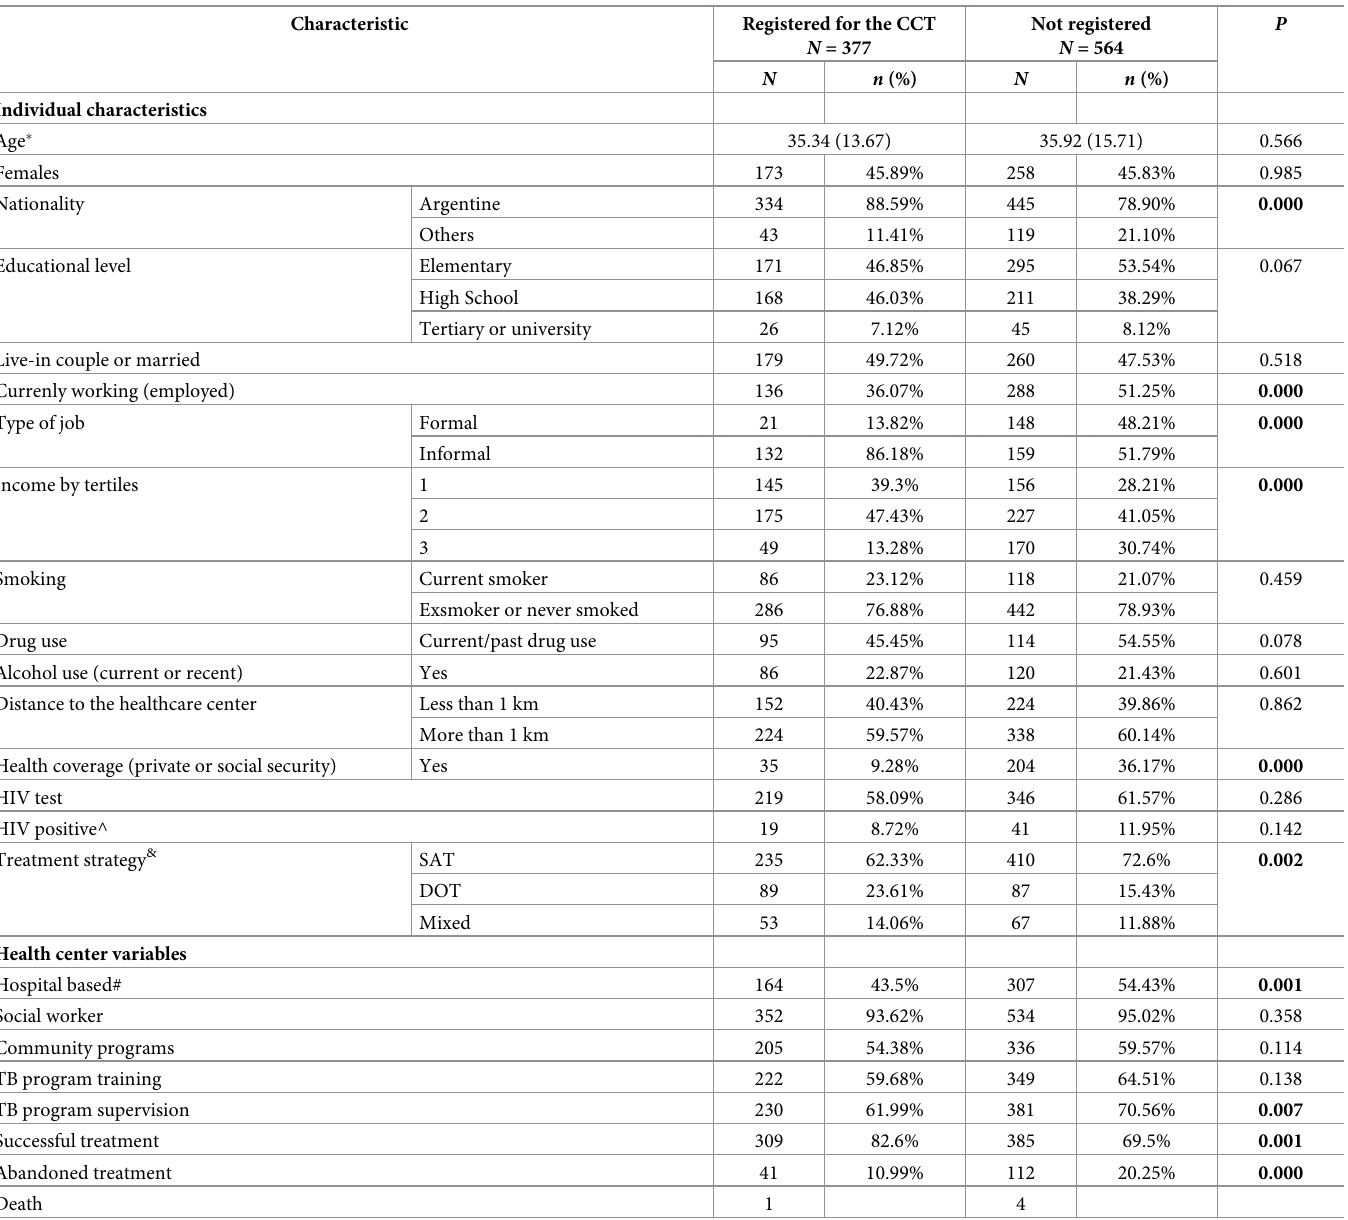
Table 1. Sociodemographic characteristics and risk factors by